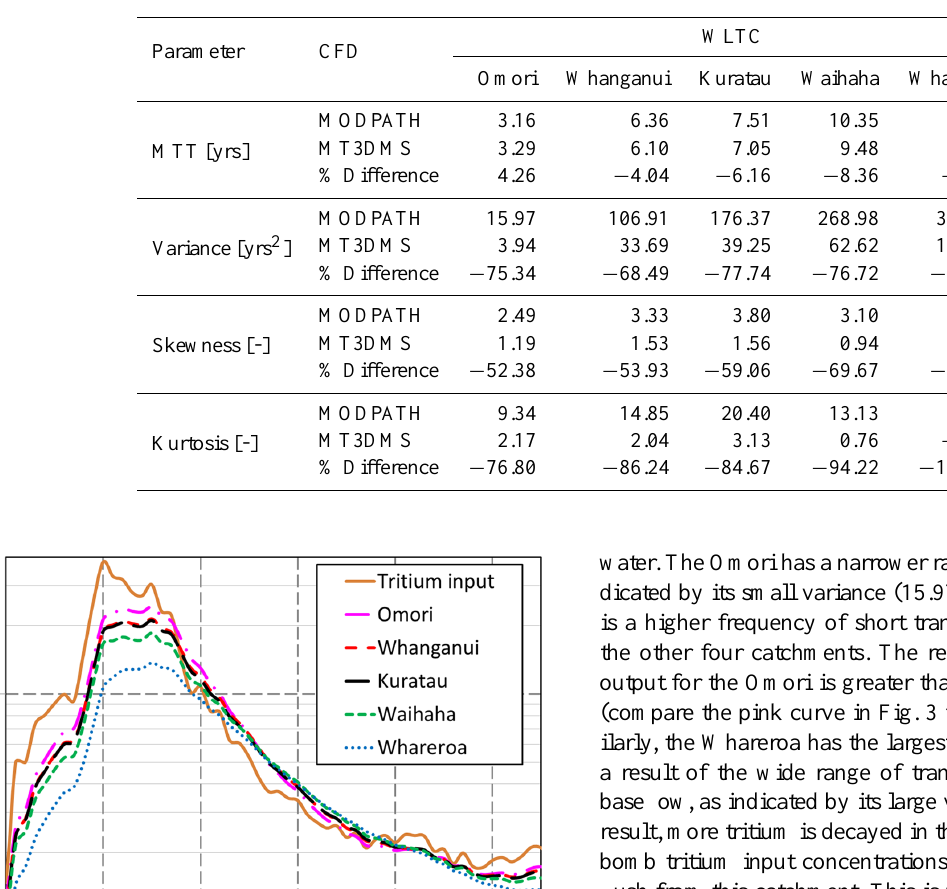
Table 1. MTT, variance, skewness, and kurtosis for MT3DMS and MODPATH as well as % difference between MT3DMS and MODPATH values of five river catchments.